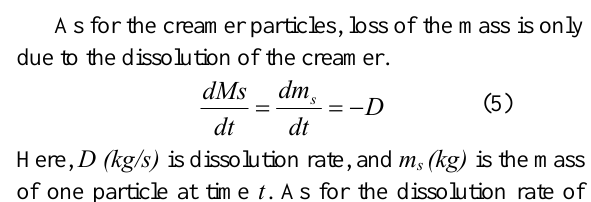
Fig. 3. The shrinking core